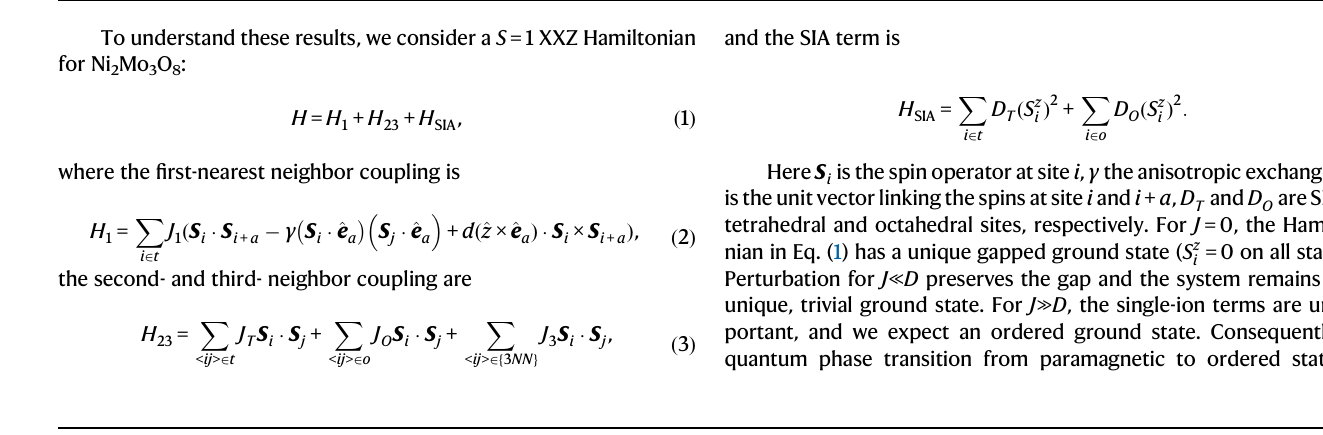
Fig. 3 | Momentum and temperature dependence of magnetic scattering in Ni 2 Mo 3 O 8 .a,b 3D and 2Dreciprocalspace of Ni 2 Mo 3 O 8 ,wherethehigh symmetry positionsaremarked. c – e Energy-momentumplotsofthedispersionsalongthe[ H , H ,0]directionat1.5,10,and120Kmeasuredwith40meVincidentneutronenergy. The data is integrated along the L direction since the scattering above 12meV has no modulation along the L direction. Dashed lines indicate the energy integration range in f – h , Momentum dependence of the magnetic scattering at 1.5, 10,